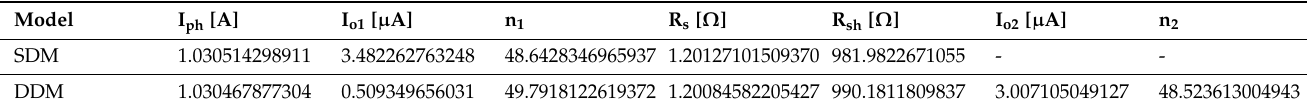
Table 6. The parameters of the PWP201 photovoltaic panel.